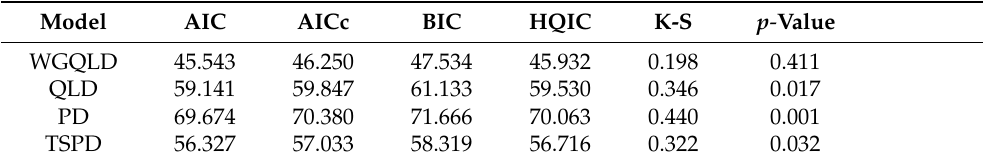
Table 8. The measures AIC, AICc, BIC, HQIC, and K-S with the corresponding p -value for patient data.